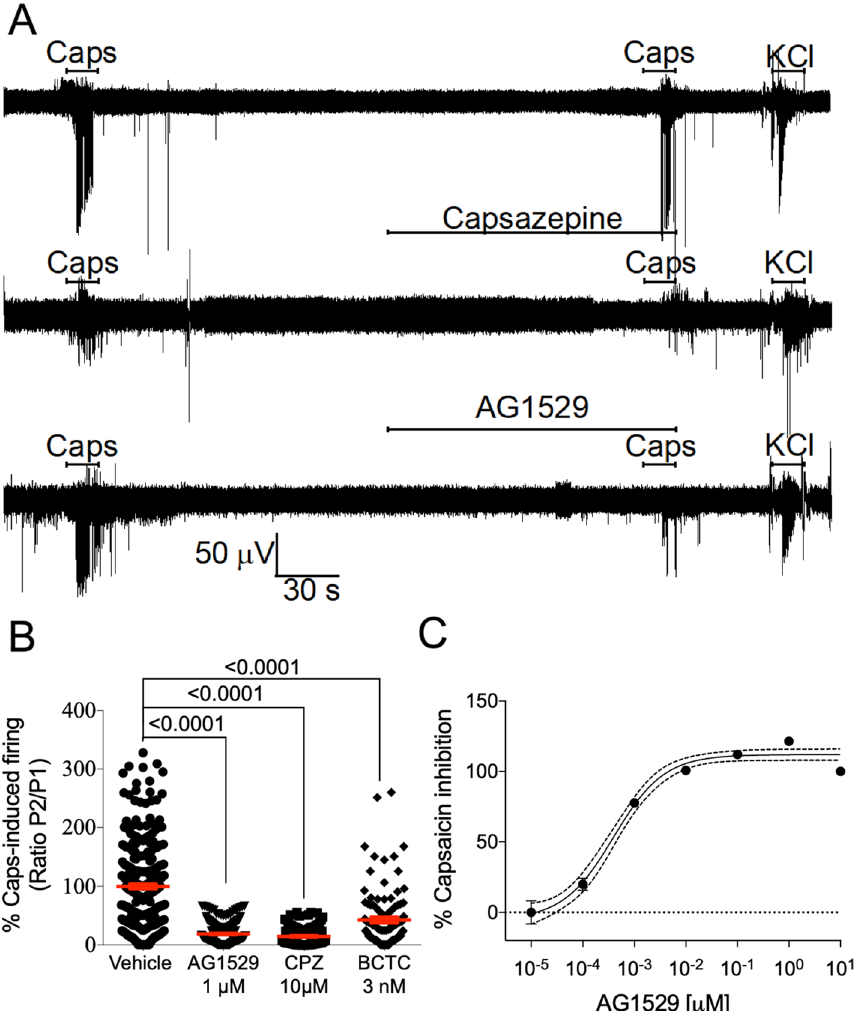
Figure 6. AG1529 attenuates capsaicin-induced nociceptor excitability. ( A ) Representative MEA recordings showing the capsaicin-evoked AP firing for control (top), 10 µM capsazepine (middle) and 1 µM AG1529 (bottom). Capsaicin (0.5 µM) was applied in two sequential pulses of 15 s interspersed with a washing period. Compounds were added 2 min before the second capsaicin pulse. The protocol was terminated with a 15 s-pulse of 40 mM KCl to ensure viability of neuronal cultures. ( B ) Normalized capsaicin-induced firing (P2/P1) in the absence (vehicle) and the presence of the antagonists (1 µM AG1529, 10 µM capsazepine, and 3 nM BCTC). ( C ) Dose–response curve of AG1529 blockade of capsaicin-induced AP firing. Data points were fitted to the Michaelis–Menten isotherm, giving an IC 50 value of 0.4 nM (95% CI, 0.3 to 0.6 nM) and an n H of 0.88 (95% CI 0.64 to 1.12). The boundary lines denote the interval confidence of the mean values. Data on panel ( B ) were analysed using the One-Way Anova (F(3,699) = 140.7, p < 0.0001) followed by the Bonferroni´s post-hoc test, p-values for statistical difference are indicated. N (independent experiments) = 3, number of electrodes 100–250 per